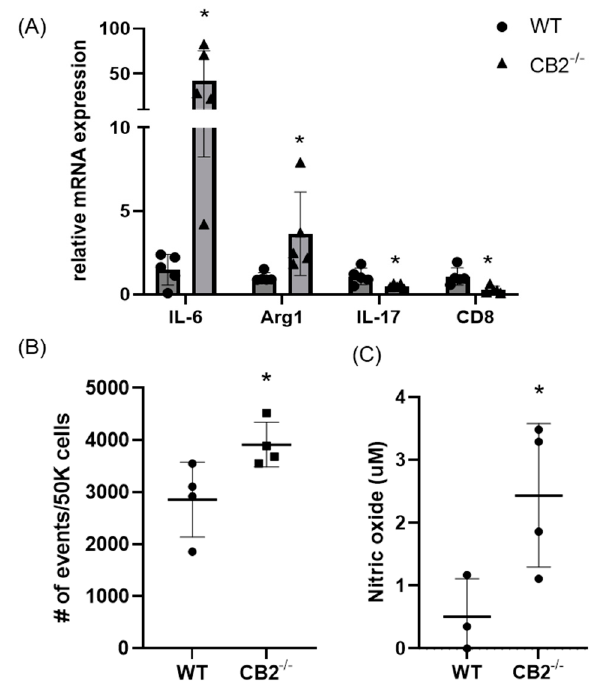
Figure 7. The CB2 receptor alters the balance between pro-tumor and anti-tumor cells and biomarkers in the TME in AOM/DSS-treated mice. ( A ) Relative mRNA expression of IL-6, arginase-1 (Arg1, functional marker of MDSCs), IL-17, and CD8 in the TME. ( B ) Relative frequency of PMN-MDSCs (CD11b+Ly6G+) in the TME. ( C ) Nitric oxide levels in the tumor microenvironment of polyps from the distal colon. WT, n ≥ 3; CB2 − / − , n ≥ 3 as indicated, Student’s t -test, * p < 0.05.